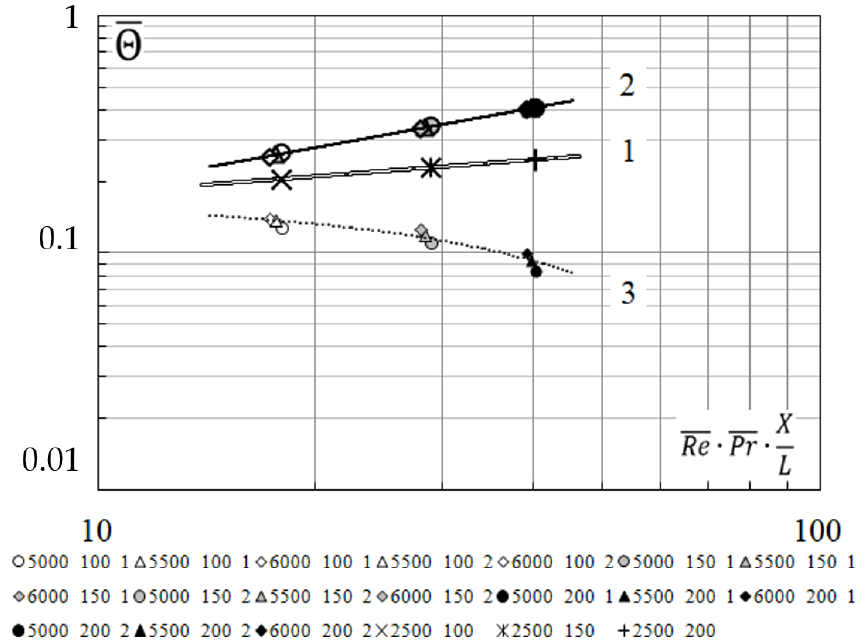
Figure 16. Generalizing dependence of dimensionless average integral temperature heads on the dimensionless coordinate. The designation of curves is similar to Figure 15.